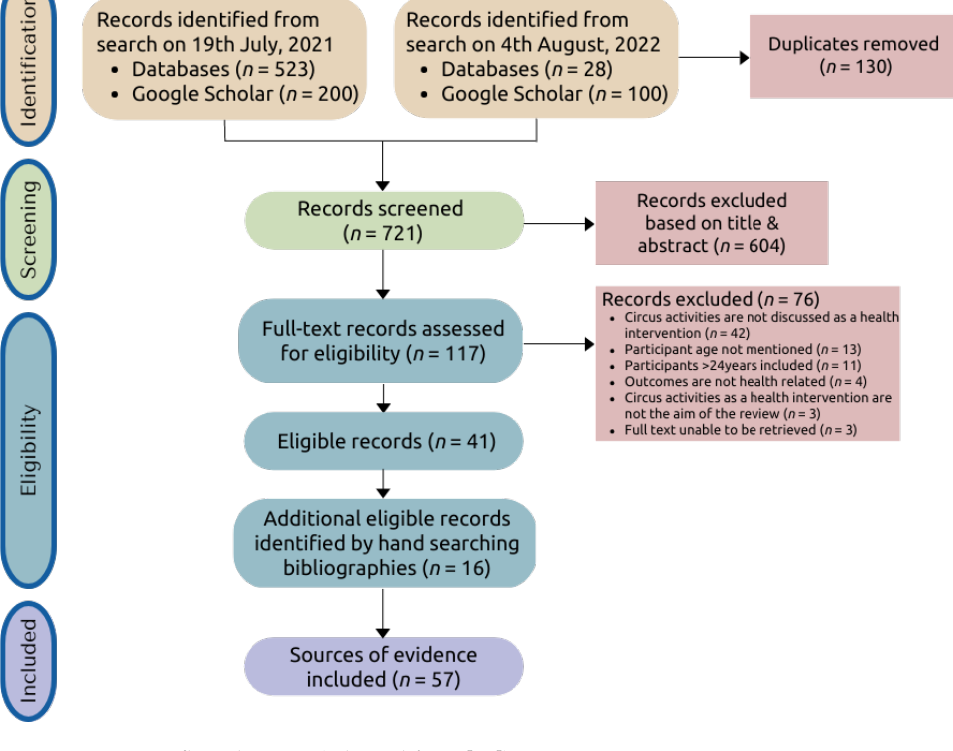
Figure 1. PRISMA flow diagram (adapted from [25]).